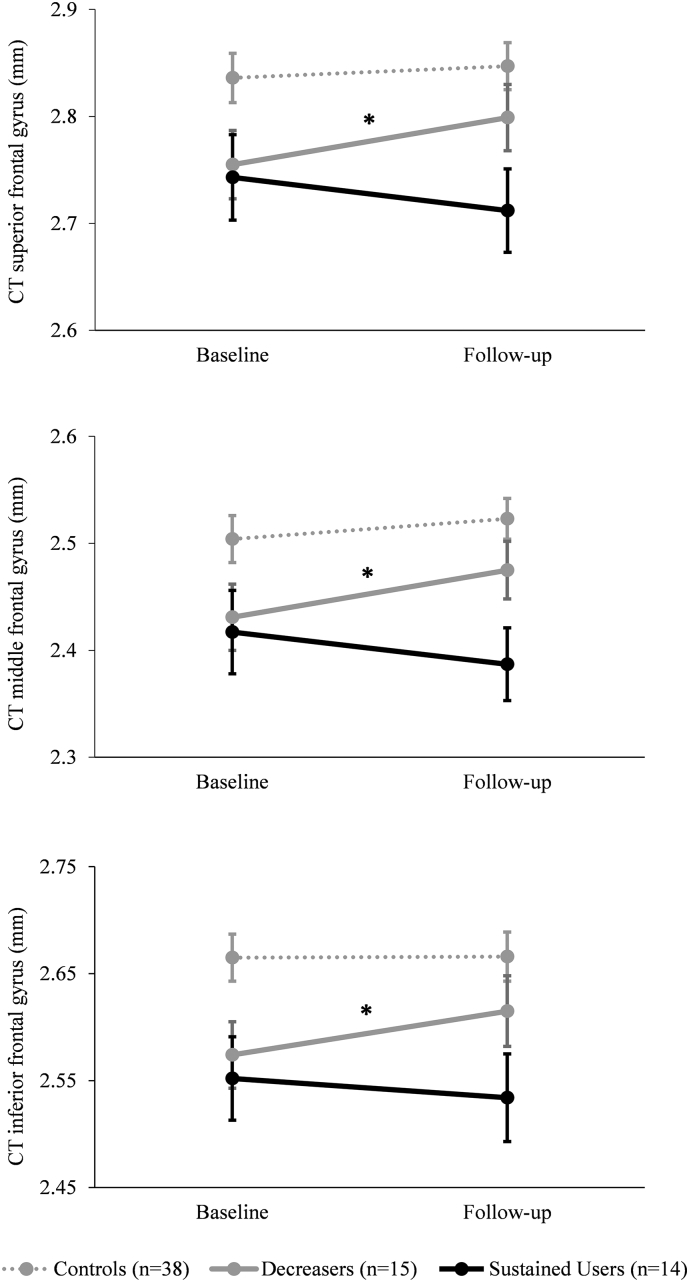
Changes in cortical thickness.Change in cortical thickness (in mm) from baseline to follow-up. Superior frontal gyrus: Decreasers P = .018 Sustained Users P = .16; Middle frontal gyrus: Decreasers P = .009 Sustained Users P = .15; Inferior frontal gyrus: Decreasers P = .022 Sustained Users P = .39;Sidak post-hoc tests: *P < .05. All analyses were corrected for verbal IQ, ADHD-SR score, the amount of alcohol consumed between baseline and follow-up, and the time interval between the two measurements.